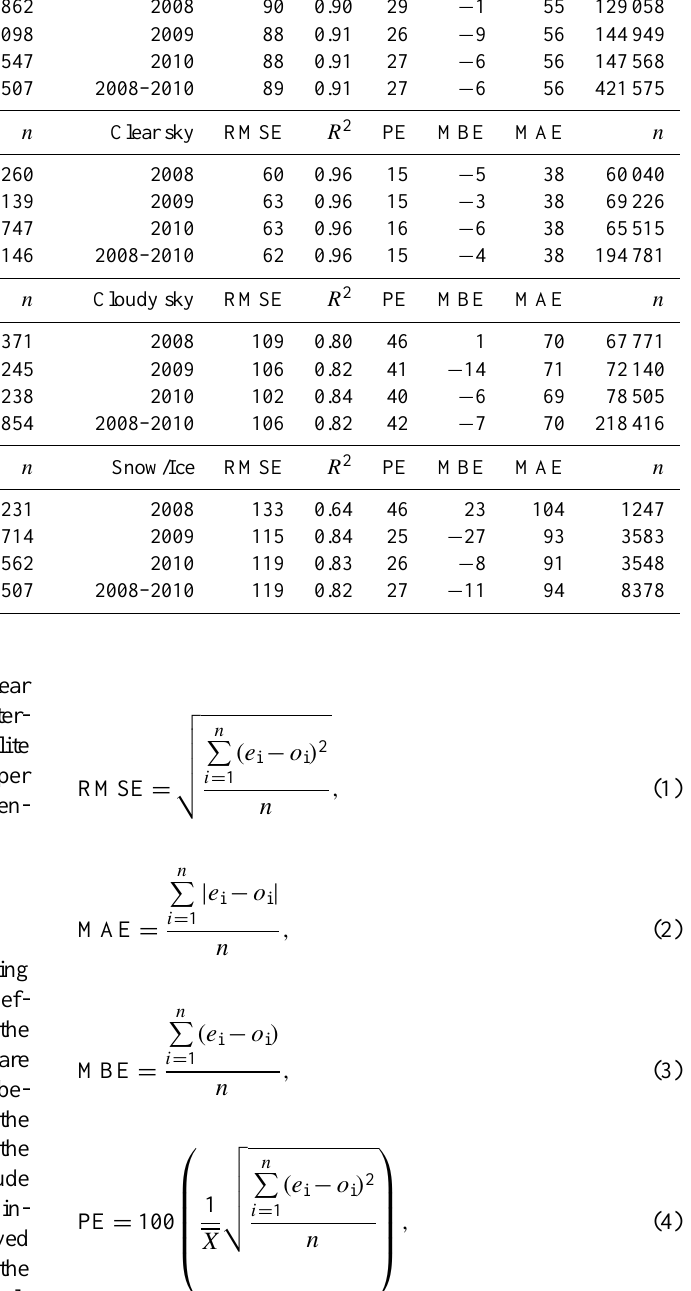
Table 3. Hourly solar radiation error and accuracy statistics depending on flat or hilly terrain, clear and cloudy sky conditions, and presence of snow or ice cover from 2008 to 2010. RMSE, MBE and MAE in Wm − 2 , PE in percentage and n is the number of samples. Flat terrain Hilly terrain All sky